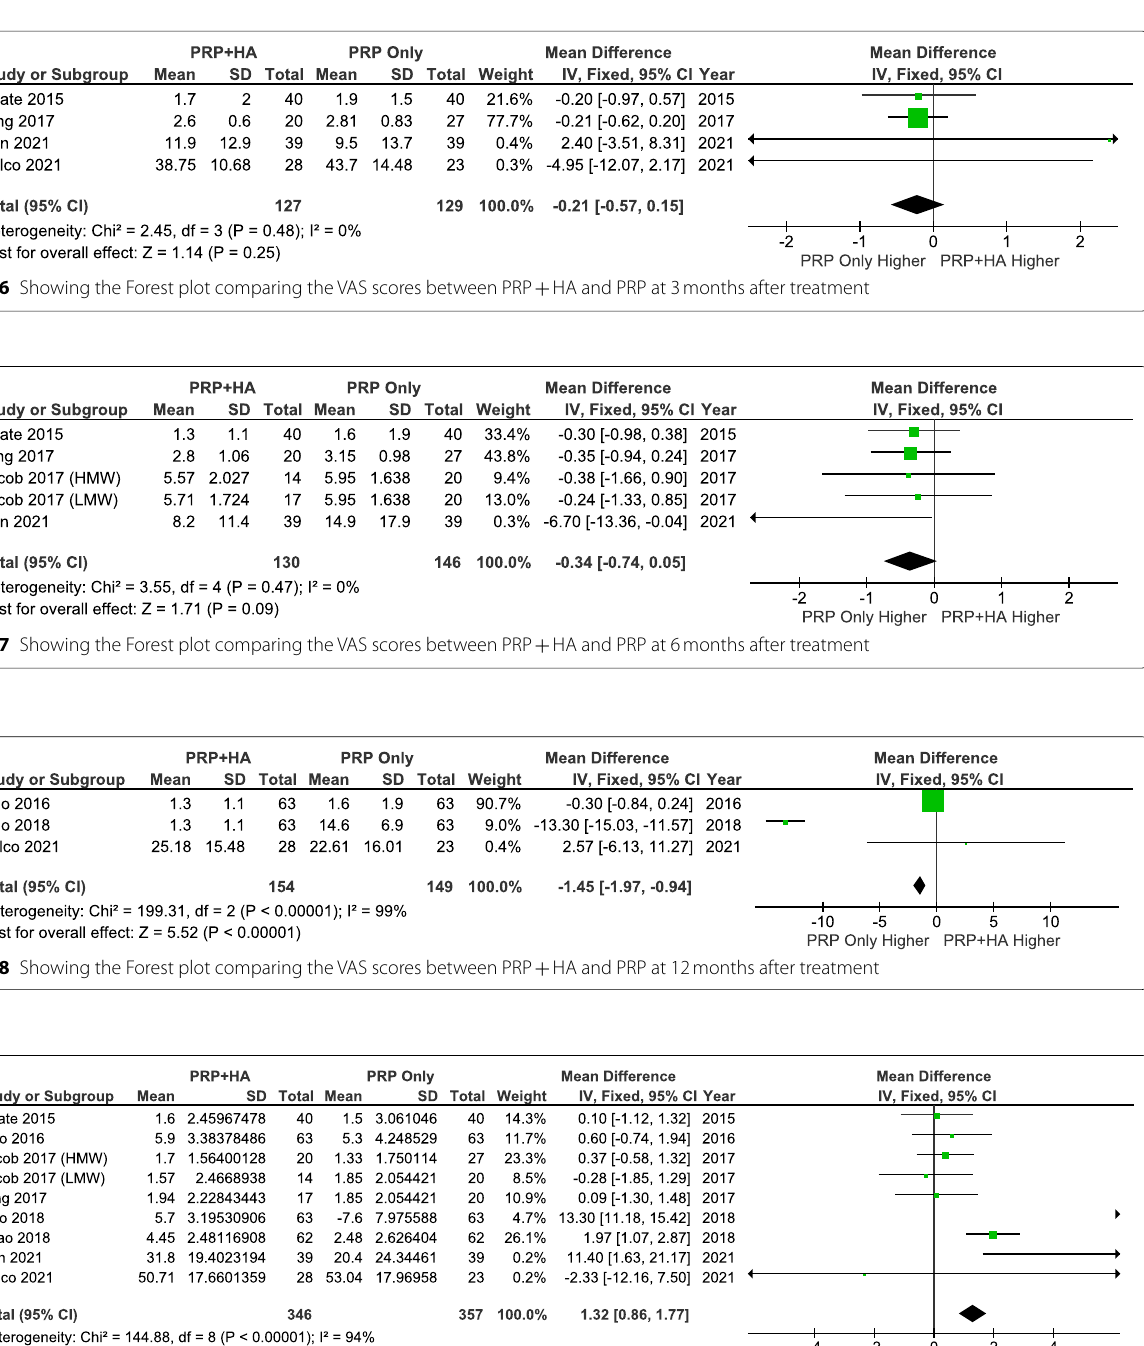
Fig. 9 Showing the Forest plot comparing the change in VAS scores between PRP